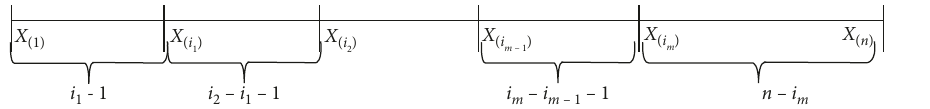
Figure 6: Order statistics of a subset of complete order statistics corresponding to the random sample x